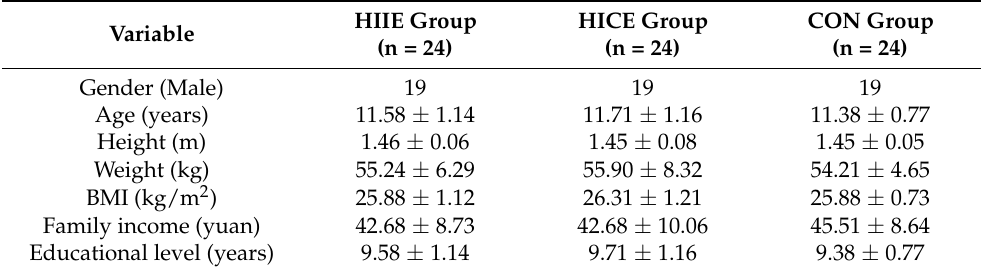
Table 1. Descriptions of the demographic data of the three